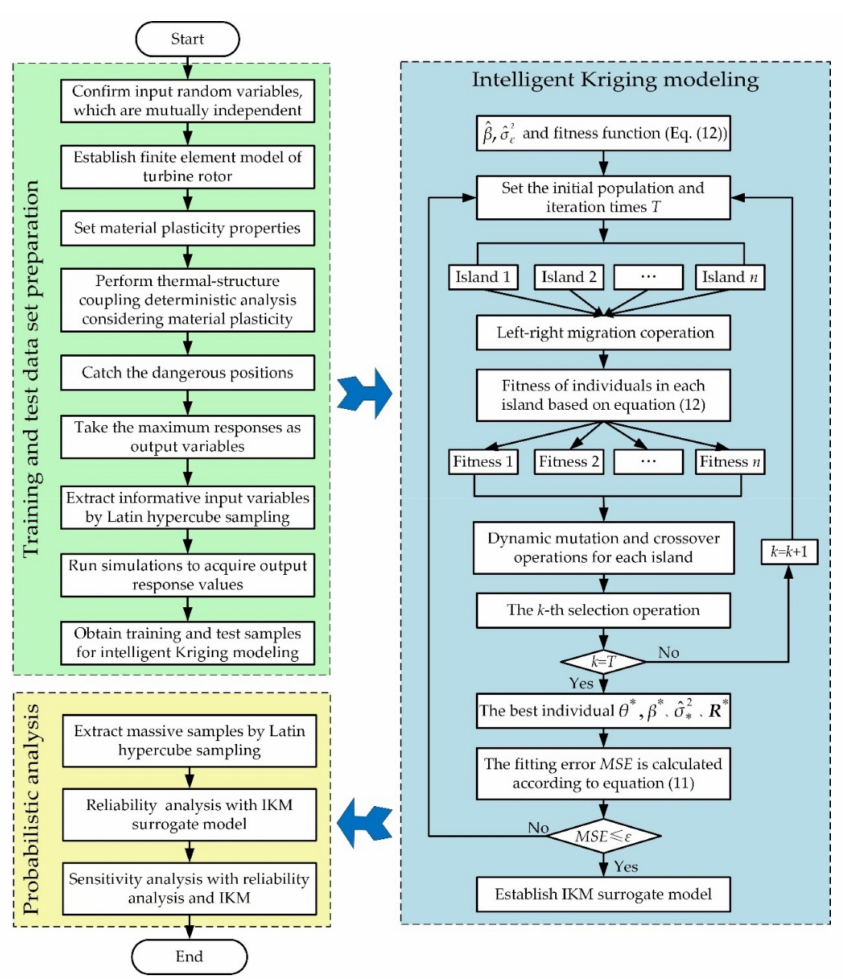
Figure 4. Flow chart of probabilistic analysis with intelligent Kriging modeling